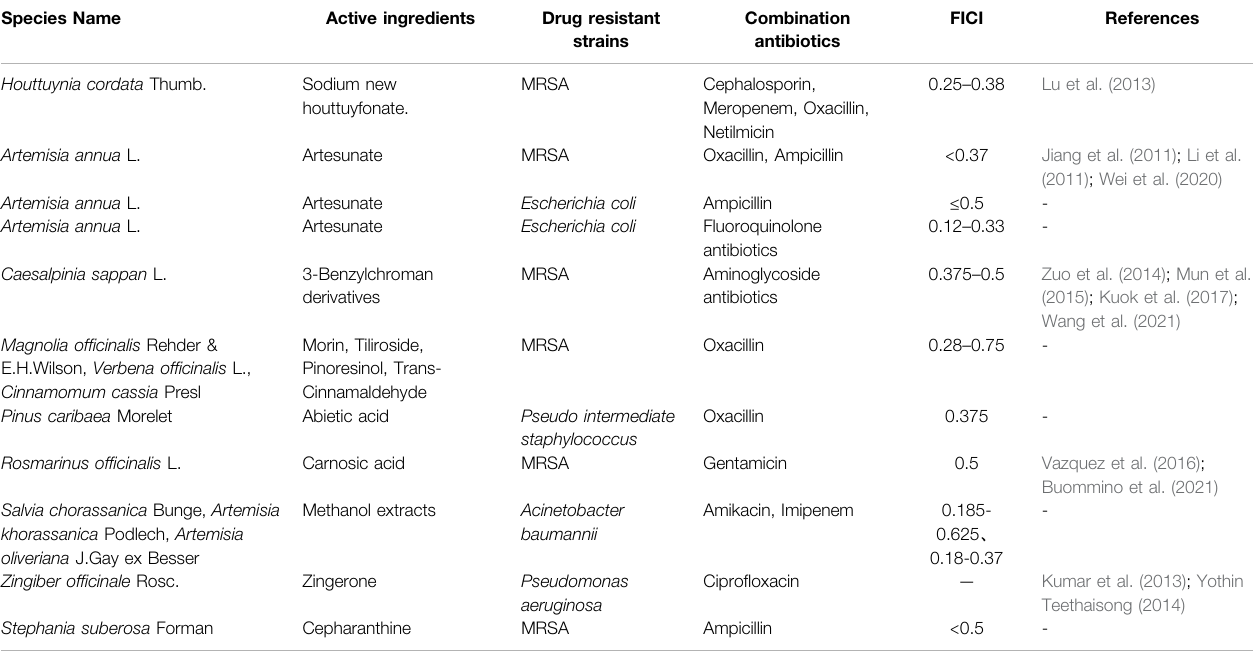
TABLE 5 | Summary of other compounds in combination with